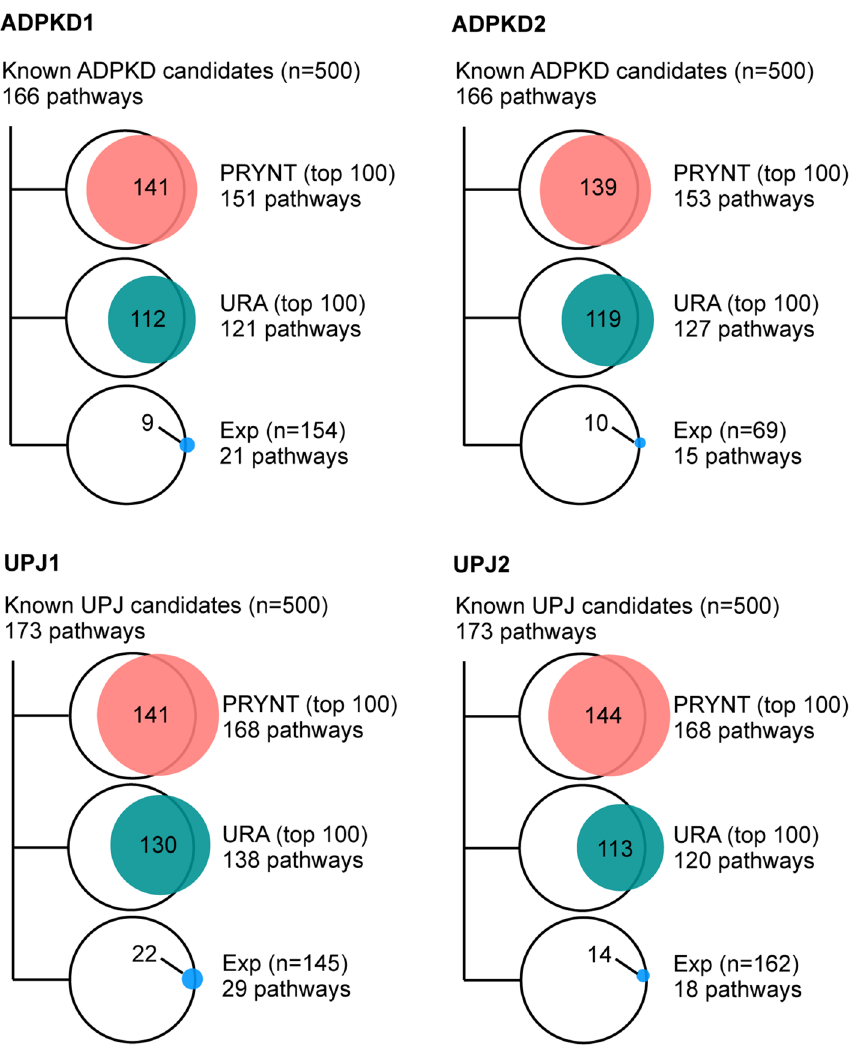
Figure 7. Pathway annotation. KEGG pathway enrichment analysis was applied to the 500 reference ADPKD and UPJ disease candidates, and compared to the pathways enriched from top 100 ranked candidates by PRYNT or URA or from the experimental urinary proteomic candidates (Exp) in the four